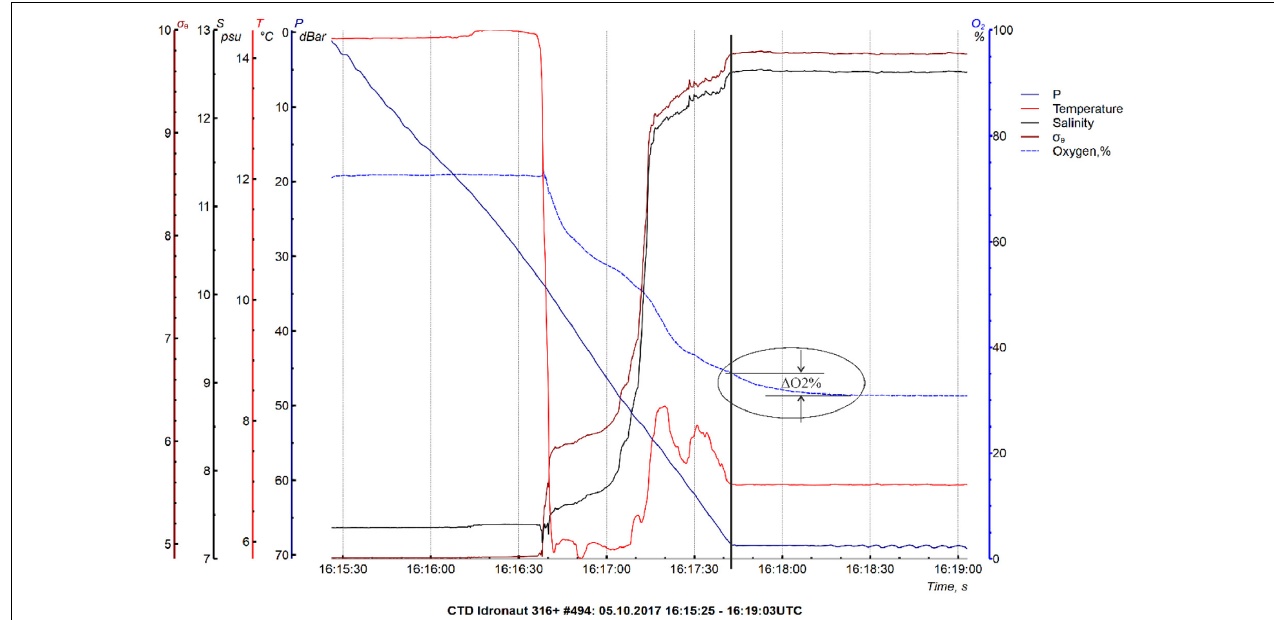
FIGURE 2 | A record of temperature T ( ◦ C), salinity S (psu), density σ θ and oxygen saturation O 2 (%) signals as functions of time during measurements at a drift station. The probe was kept on the ground for 1 min before recovery as can be seen from the pressure signal. The black vertical line marks the moment of reaching the bottom and the start of holding the probe at the bottom. The space between the horizontal lines placed in the ellipse shows the change (cid:49) O 2 (%) in the oxygen saturation signal due to the oxygen sensor inertia. Note that the rest of the parameters, T and S, remained unchanged at this time.